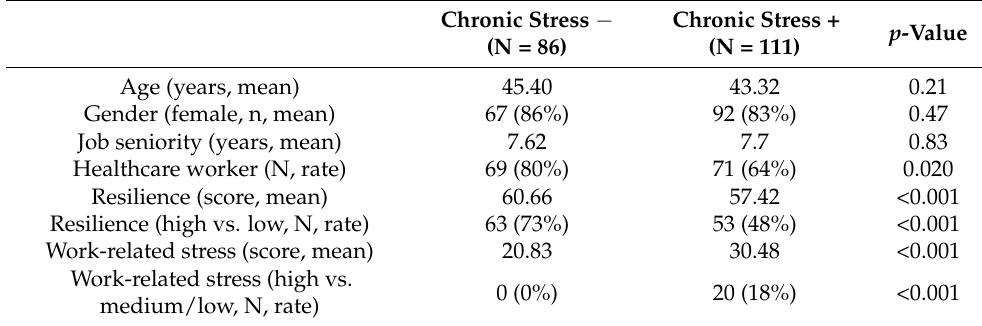
Table 2. Descriptive statistics of the 197 respondents to Q1. The tests compare respondents with a chronic stress scores higher and lower than the predefined threshold